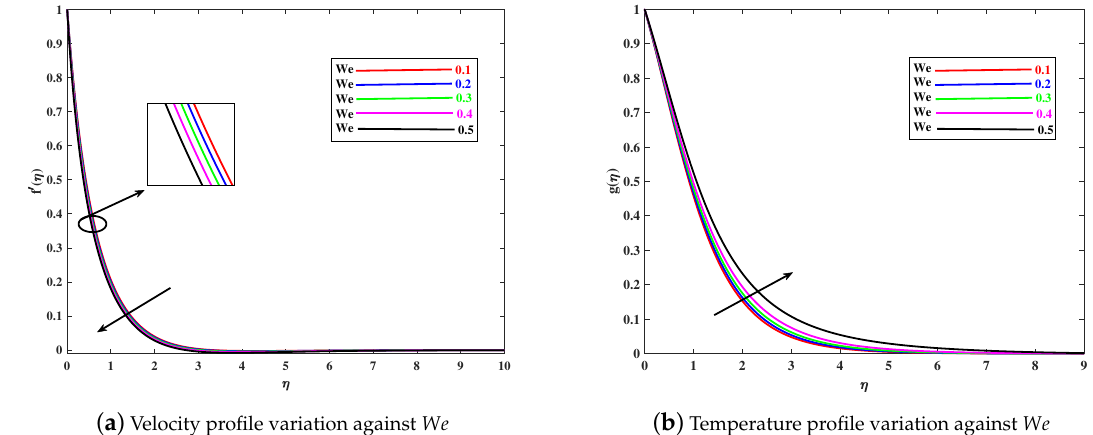
Figure 4. Effect of We to influence the momentum and thermal